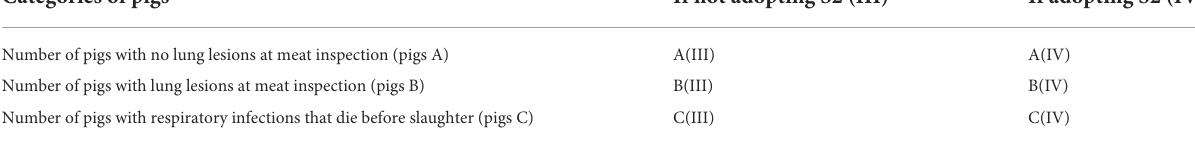
TABLE 5 Categories of finishing pigs used in the partial budget model when either adopting or not adopting the strategy of keeping purchases gilts separated (S2).